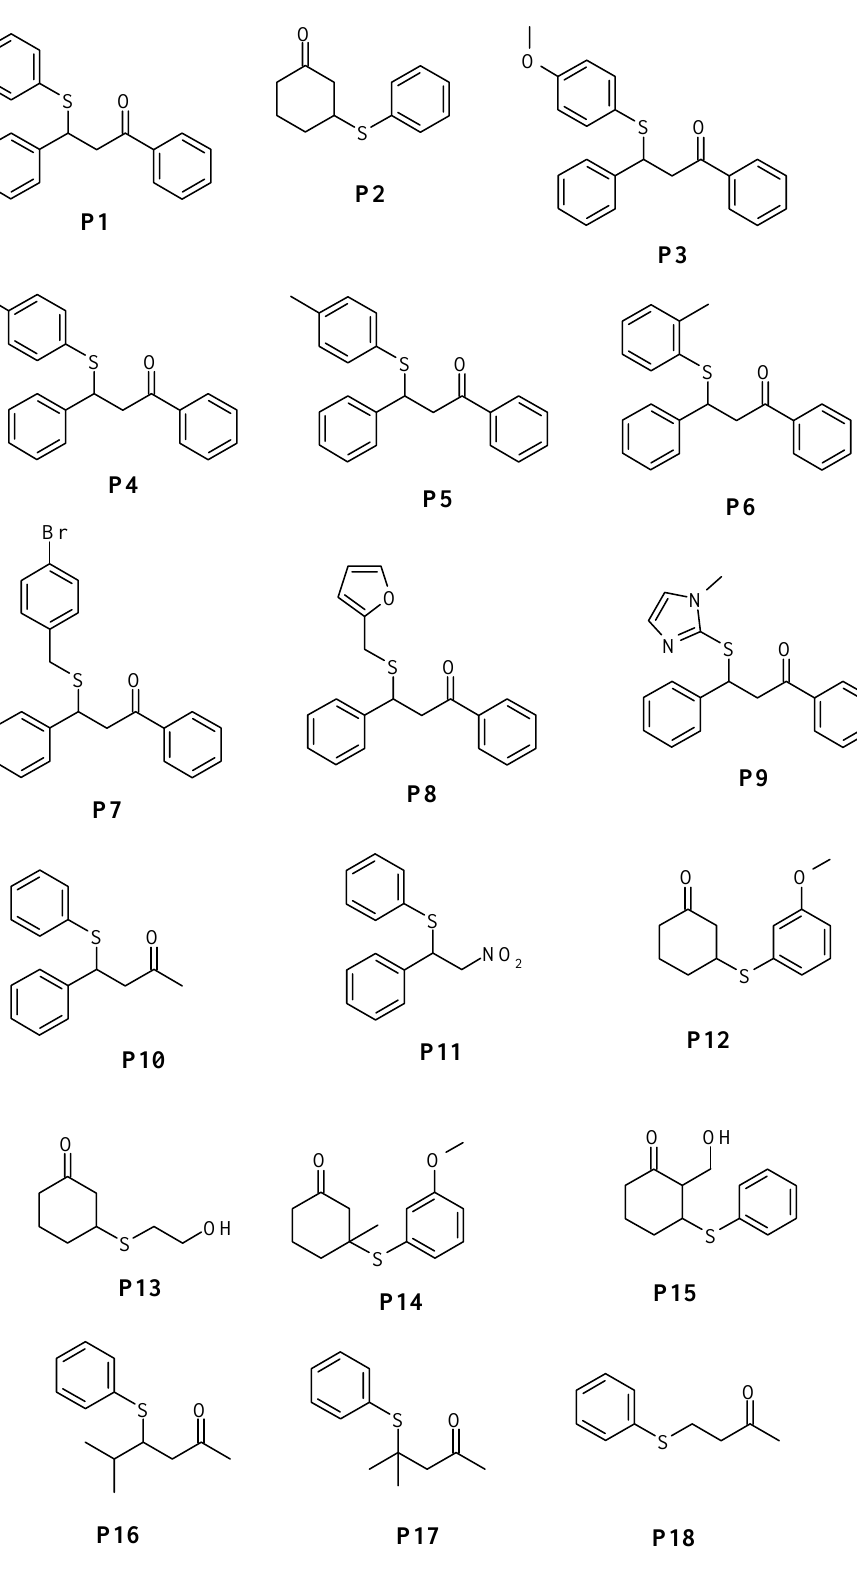
Figure 3 . Structures of